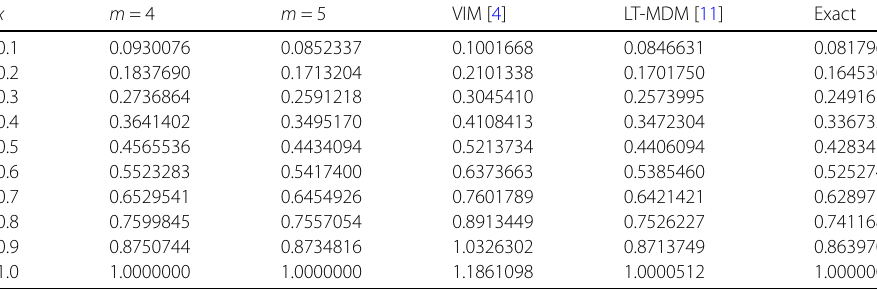
Table 3 Approximated solutions utilizing approach II for λ =